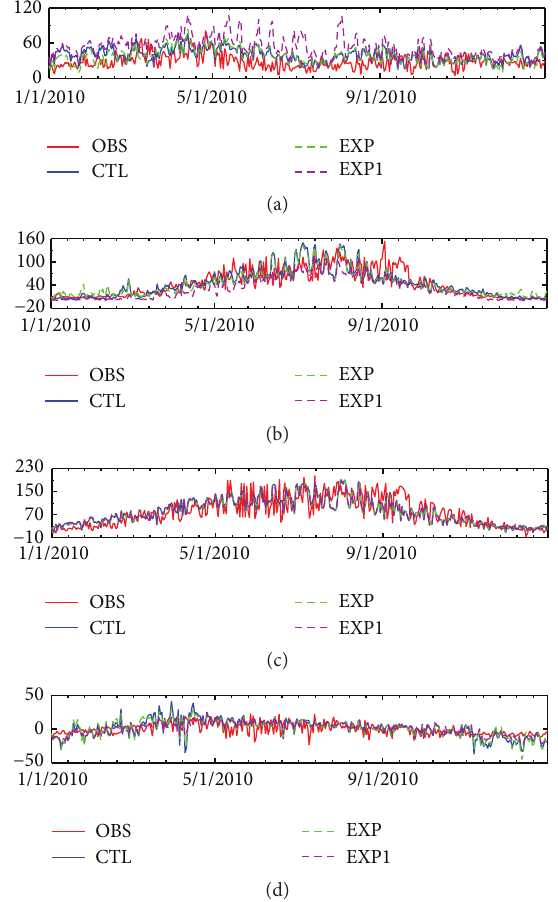
Figure 13:Same asFigure 12butdaily mean variationsof energy flux between observation and